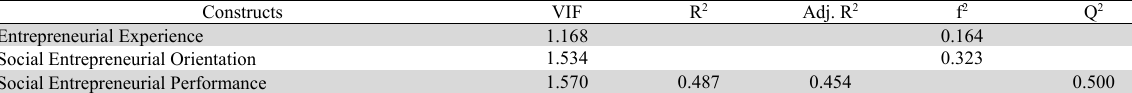
Fig. 1. Full Model Result